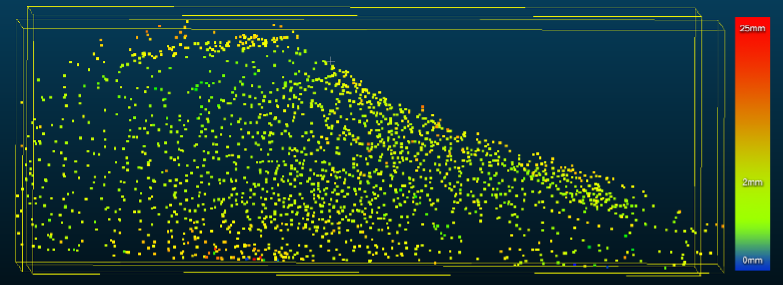
Figure 9. Point cloud of model foot taken with 4 ◦ resolution. The color of the points indicates the distance between the point and the nearest mesh surface from an optical image of model foot (not shown for clarity). The average is 2.9 mm, but some outliers ( ∼ 25 mm) are still taken as valid